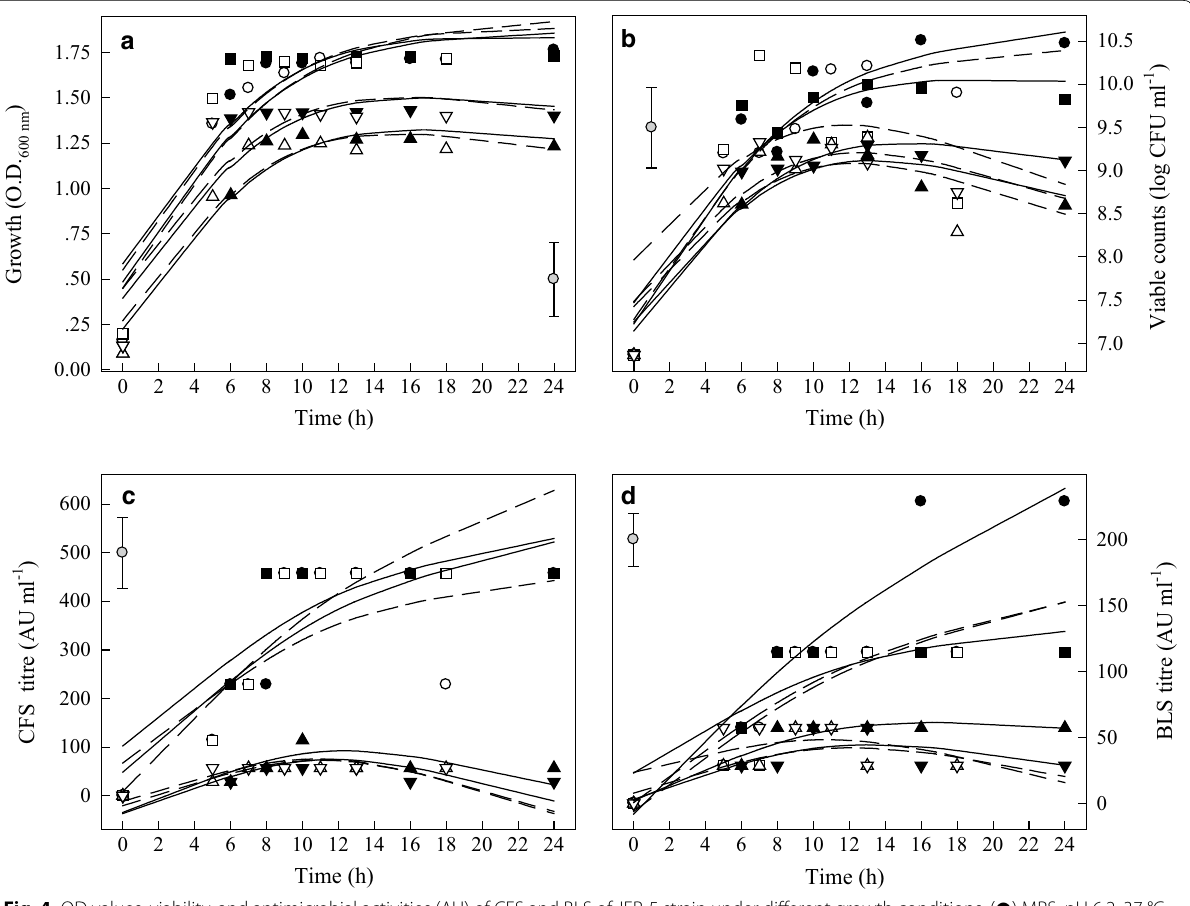
Fig. 4 OD values, viability, and antimicrobial activities (AU) of CFS and BLS of JFR-5 strain under different growth conditions. ( ● ) MRS, pH 6.2, 37 °C; ( ○ ) MRS, pH 6.2, 44 °C; ( ■ ) MRS, pH 7.4, 37 °C; ( □ ) MRS, pH 7.4, 44 °C; ( ▲ ) BHI, pH 5.5, 37 °C; ( △ ) BHI, pH 5.5, 44 °C; ( ▼ ) BHI, pH 6.2, 37 °C; ( ▽ ) BHI, pH 6.2, 44 °C. a Optical density (OD); b LAB viable counts; c antimicrobial activity of CFS and d antimicrobial activity of BLS. The experimental data were fitted to the logistic model. The vertical bar represents standard errors of the